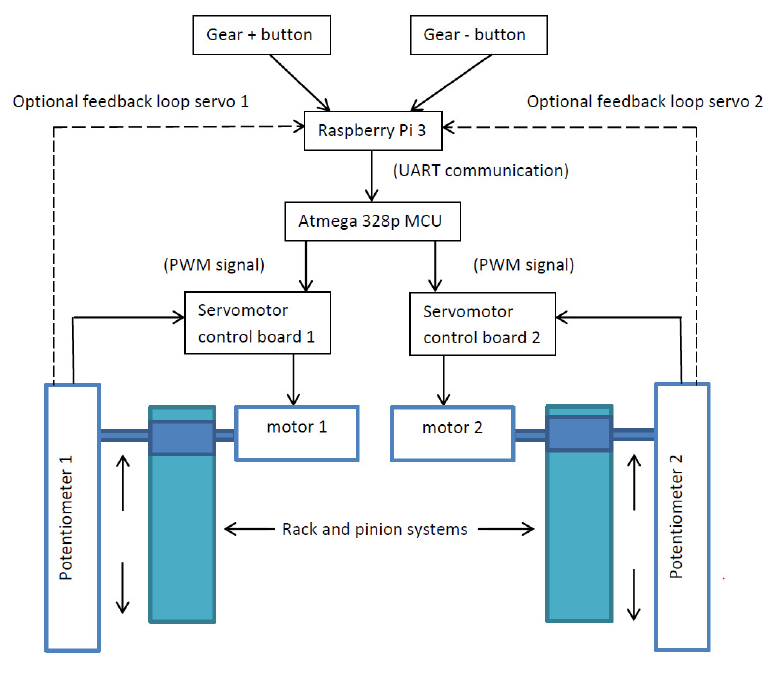
Figure 7. Layout and logic of the electronic